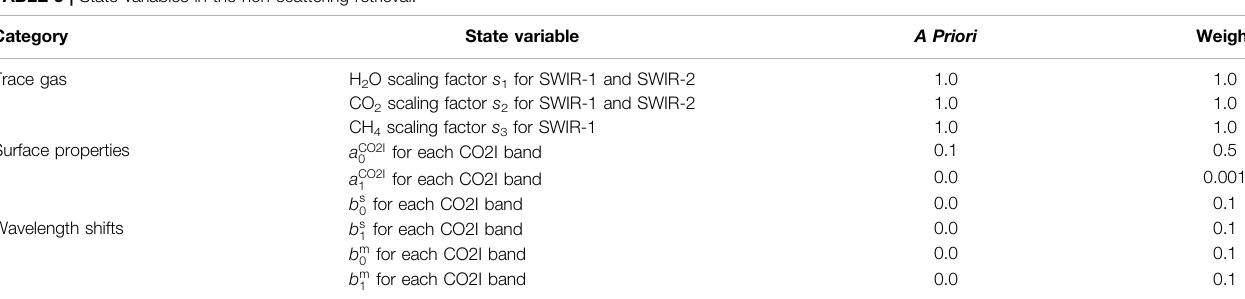
TABLE 5 | State variables in the non-scattering